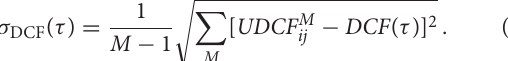
while the peak at 1,060 is the most prominent. At this ∼ value, ICCF also reaches the largest value for the symmetric and interpolated-continuum cases, see Figure 2 (left panel), while the interpolated-line case peaks at larger time-delays. This offset may be due to the fact that the line-emission dataset is not so densely covered as the continuum light curve, which leads to artifacts when interpolating it to denser continuum light